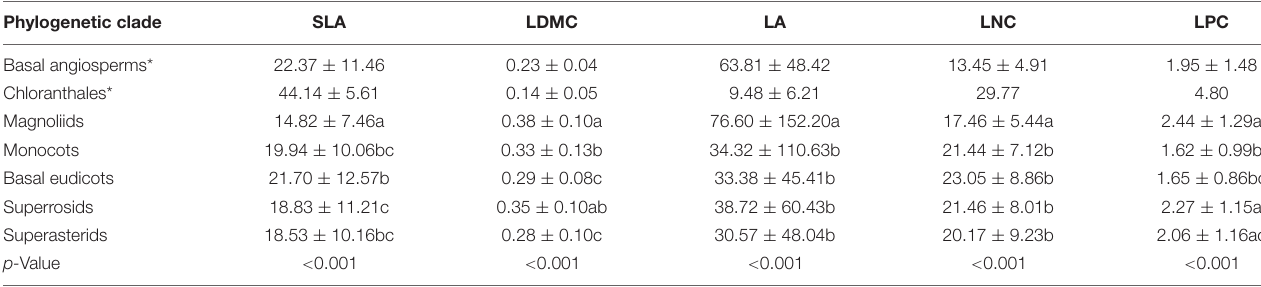
TABLE 3 | Differences in the five leaf traits among phylogenetic clades. Phylogenetic